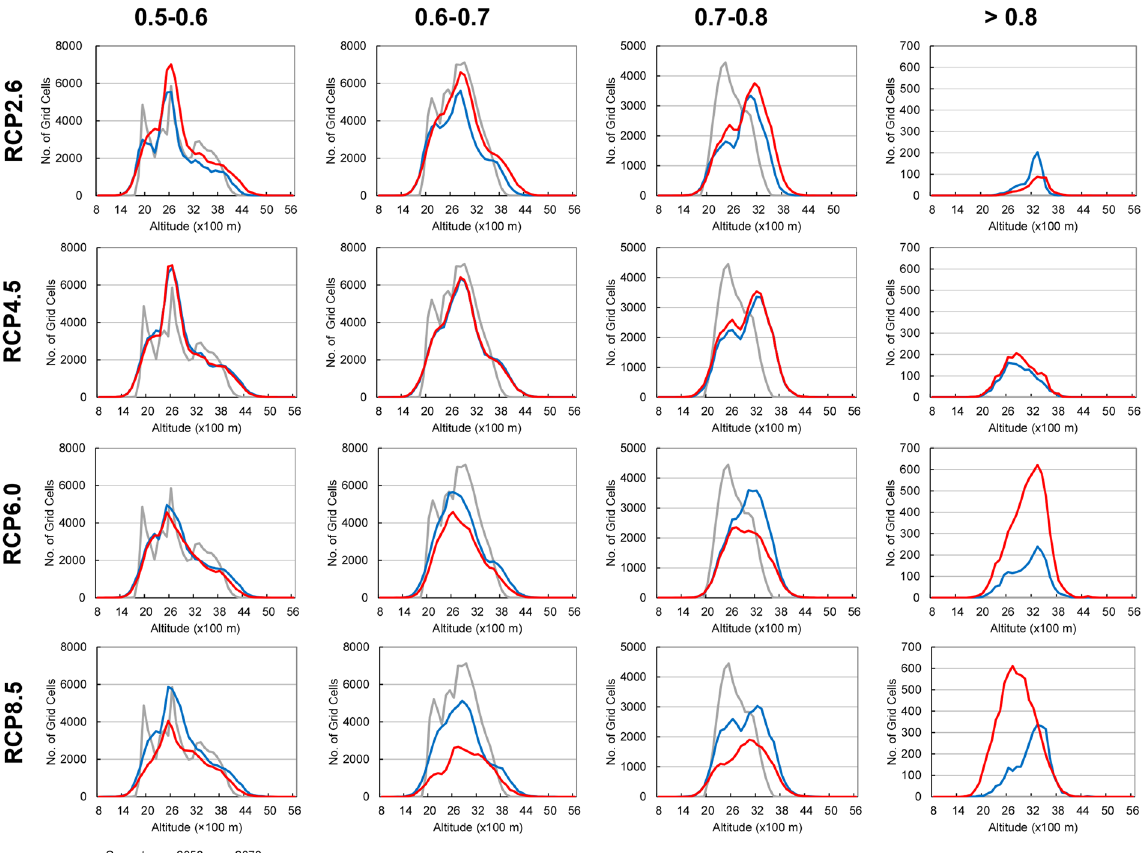
RCP6.0, RCP8.5) in the 2050 s and 2070